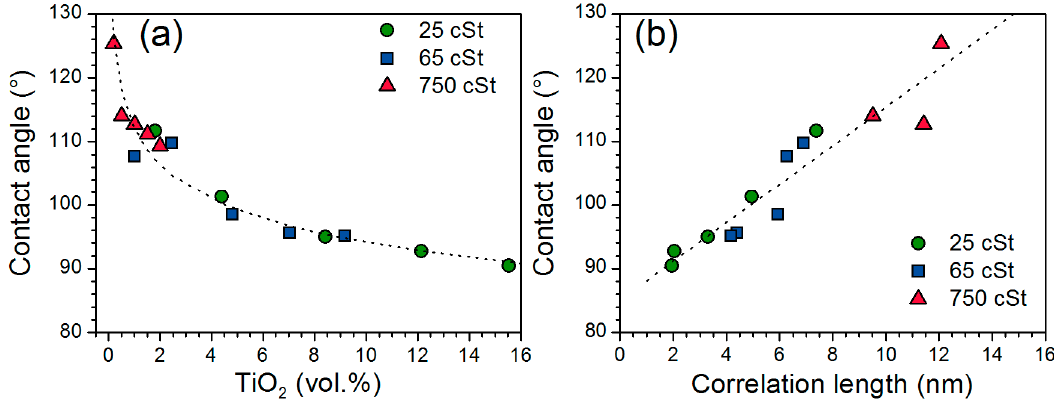
Figure 6. Contact angle of water (±1°) as a function of ( a ) the TiO 2 vol. % of the hybrid materials with power regression and ( b ) the correlation length of the titania-like nanodomains measured by SAXS with linear regression.